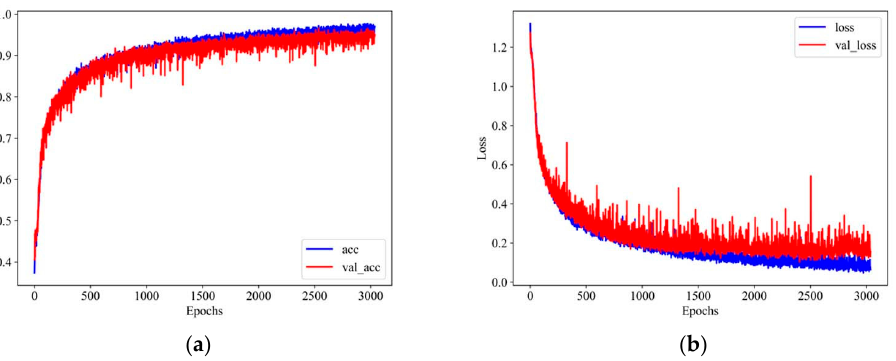
Figure 9. Typical training processes about (a) accuracy and (b) loss.